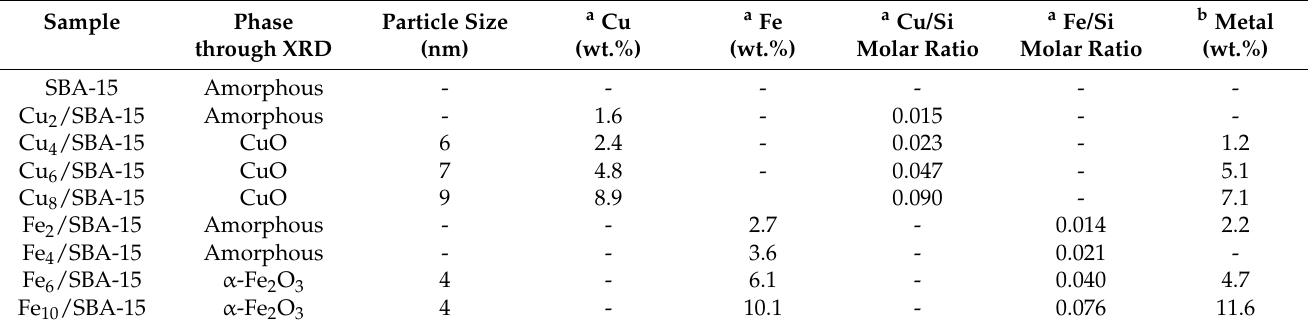
Table 1. Phases identified through XRD and composition of the catalysts in